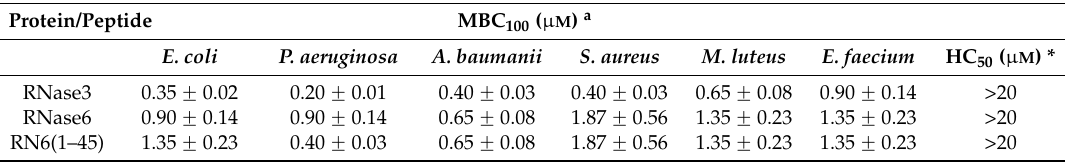
Table 4. Minimal bactericidal concentration (MBC 100 ) and hemolytic activity (HC 50 ) of RNase3, RNase6 and RN6(1–45).